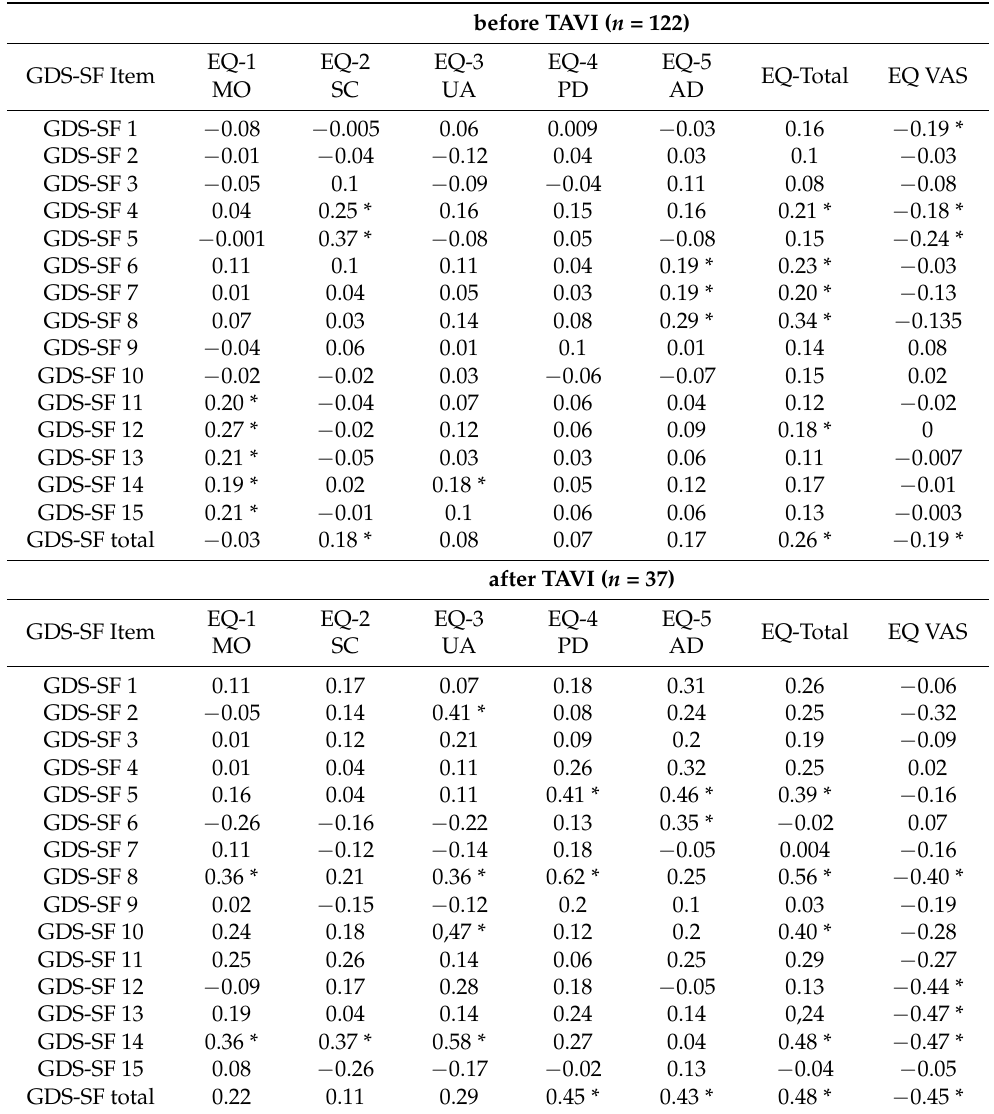
Table 3. Correlations between the GDS-SF and EQ-5D-3L items before and after TAVI (* p < 0.05). before TAVI ( n =